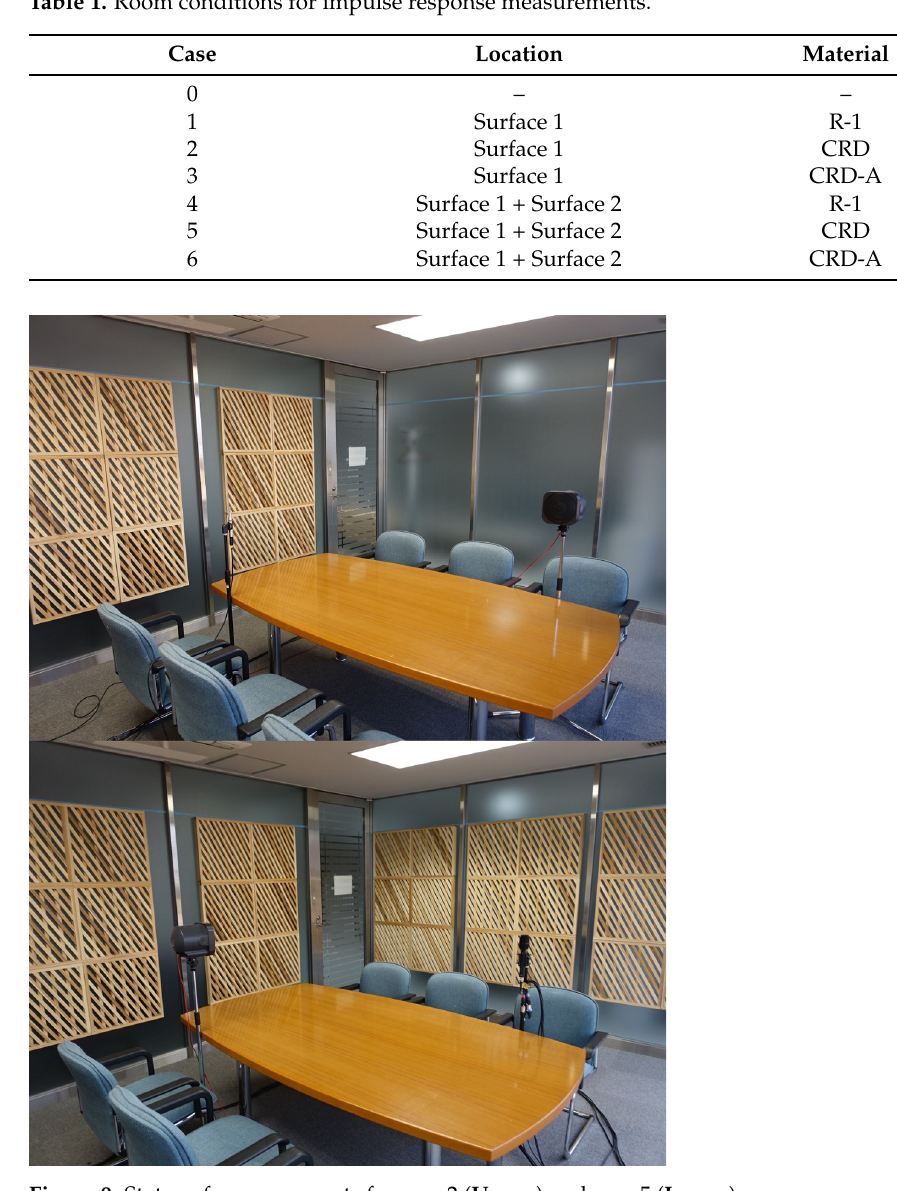
Figure 9. Status of measurements for case 2 ( Upper ) and case 5 ( Lower